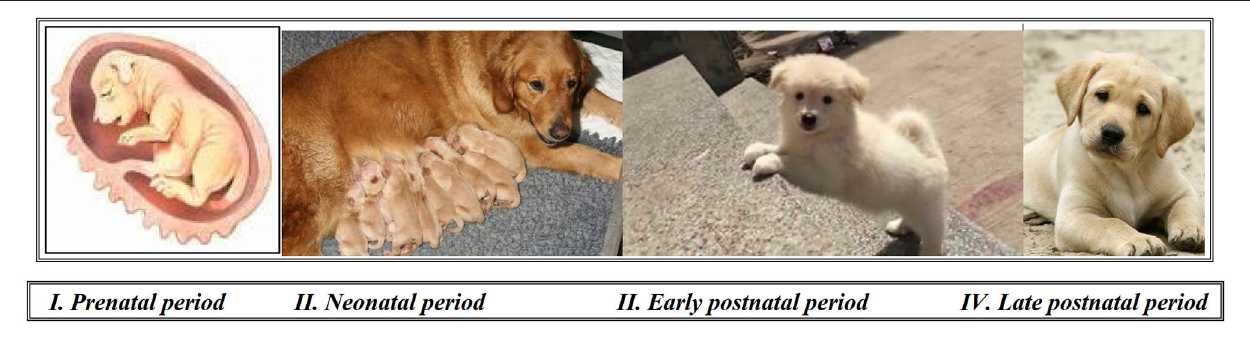
FIGURE 2 | Pathway of the study variables at different time points. Prenatal period image adapted from https://dogs.lovetoknow.com/wiki/Canine_Gestation, neonatal period image adapted from https://www.yorkbeach.co.uk/puppies/daisy_2016.html, early postnatal period image adapted from https://i.ytimg.com/vi/ 8nt7M12CTa0/maxresdefault.jpg, and late postnatal period image adapted from https://www.pets4homes.co.uk/pet-advice/what-to-expect-of-your-puppy-at-4-to-